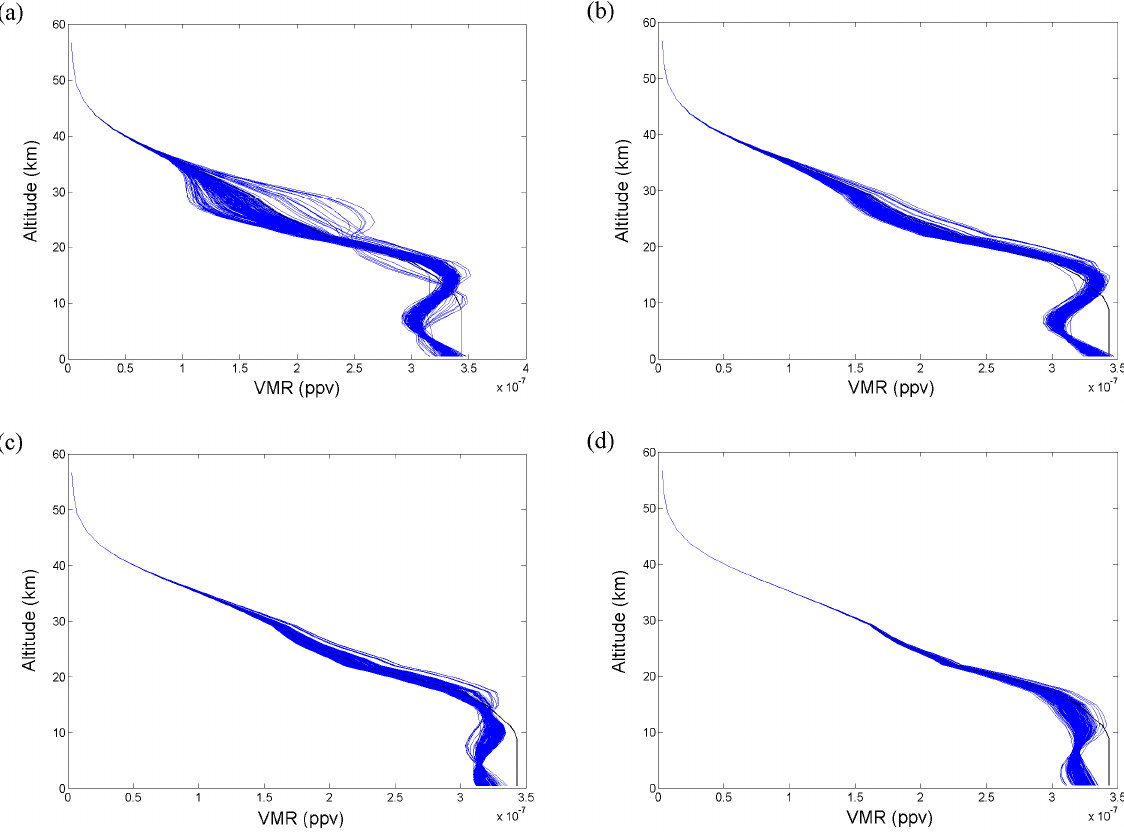
Figure 1. N 2 O profiles from all spectra taken at St.-Denis during the 2007 campaign, retrieved with the (a) OEM and with the IOA with threshold (b) 0.09, (c) 0.79 and (d) 0.99, respectively. The black line corresponds to the a priori profile used.